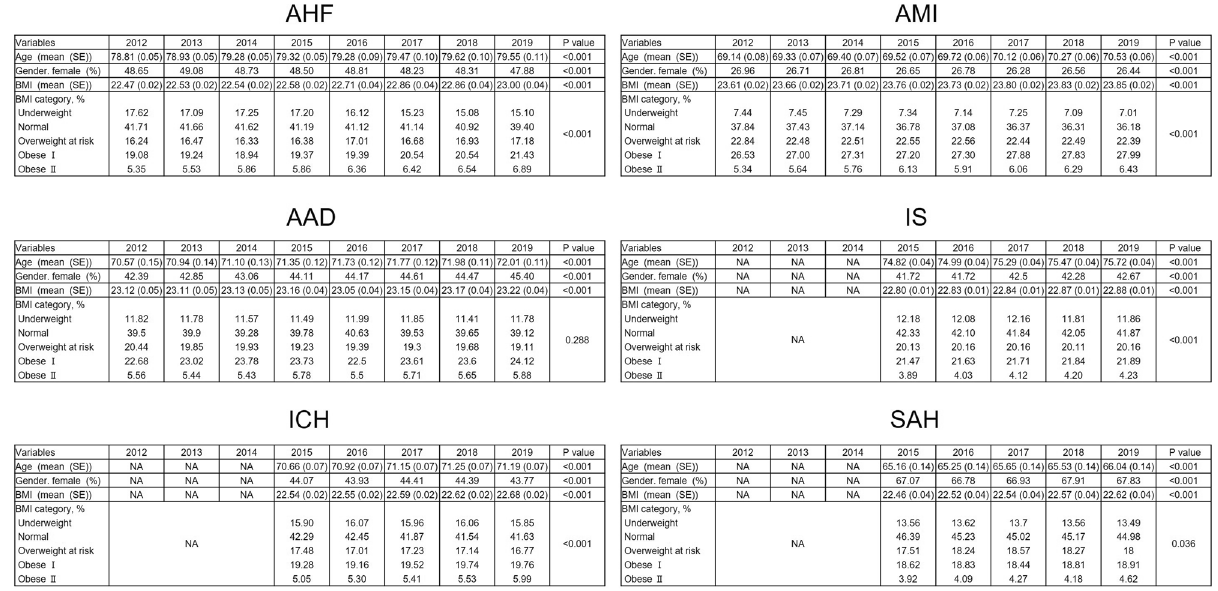
Figure 2. Trends in BMI categories and ages over time in the indicated cardiovascular disease (CVD) groups. Trends in BMI categories and ages from 2012 to 2019 in AHF, AMI, AAD and from 2015 to 2019 in IS, ICH, and SAH are shown. The Cochran-Armitage test was used to assess BMI trends over time. AAD acute aortic dissection, AHF acute heart failure, AMI acute myocardial infarction, BMI body mass index, ICH intracerebral hemorrhage, IS ischemic stroke, NA not applicable, SAH subarachnoid hemorrhage.